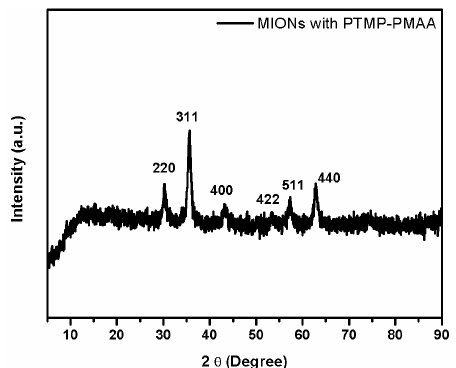
Figure 6. X-ray powder diffraction (XRD) spectrum of MIONs prepared with